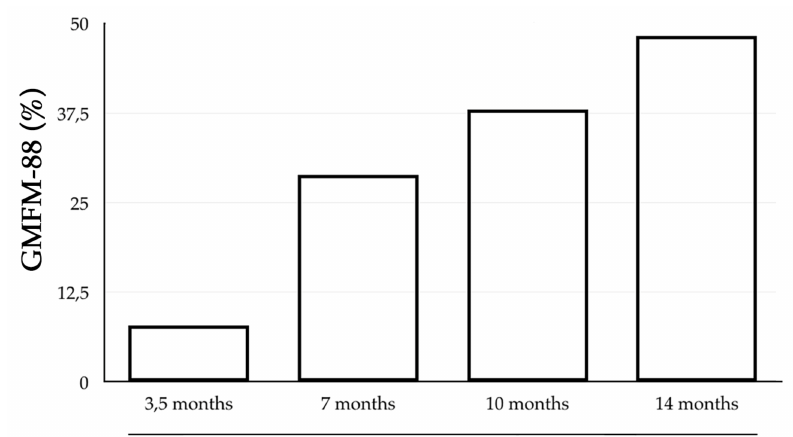
Figure 2. Motor evolution of the patient as indicated by the scores (%) reached in the Gross Motor Function Measure (GMFM-88) scale. Note that the value achieved at discharge (14 months) corresponds to the mean of normality (50.26 ± 4.36, mean ± SD) in children of similar age to that of the patient. In the revisions carried out 14 months and 5 years after discharge, no motor abnormalities